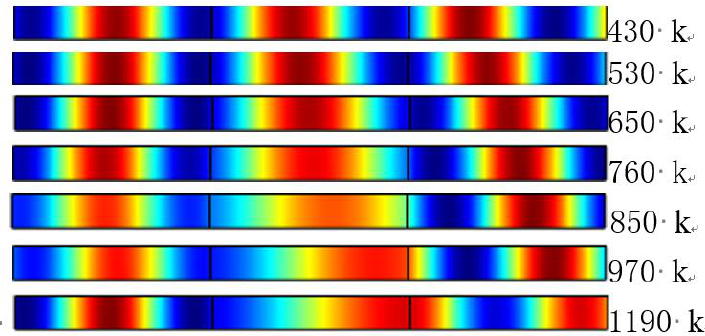
Figure 3. Acoustic pressure distribution of transmission unit at different temperatures.